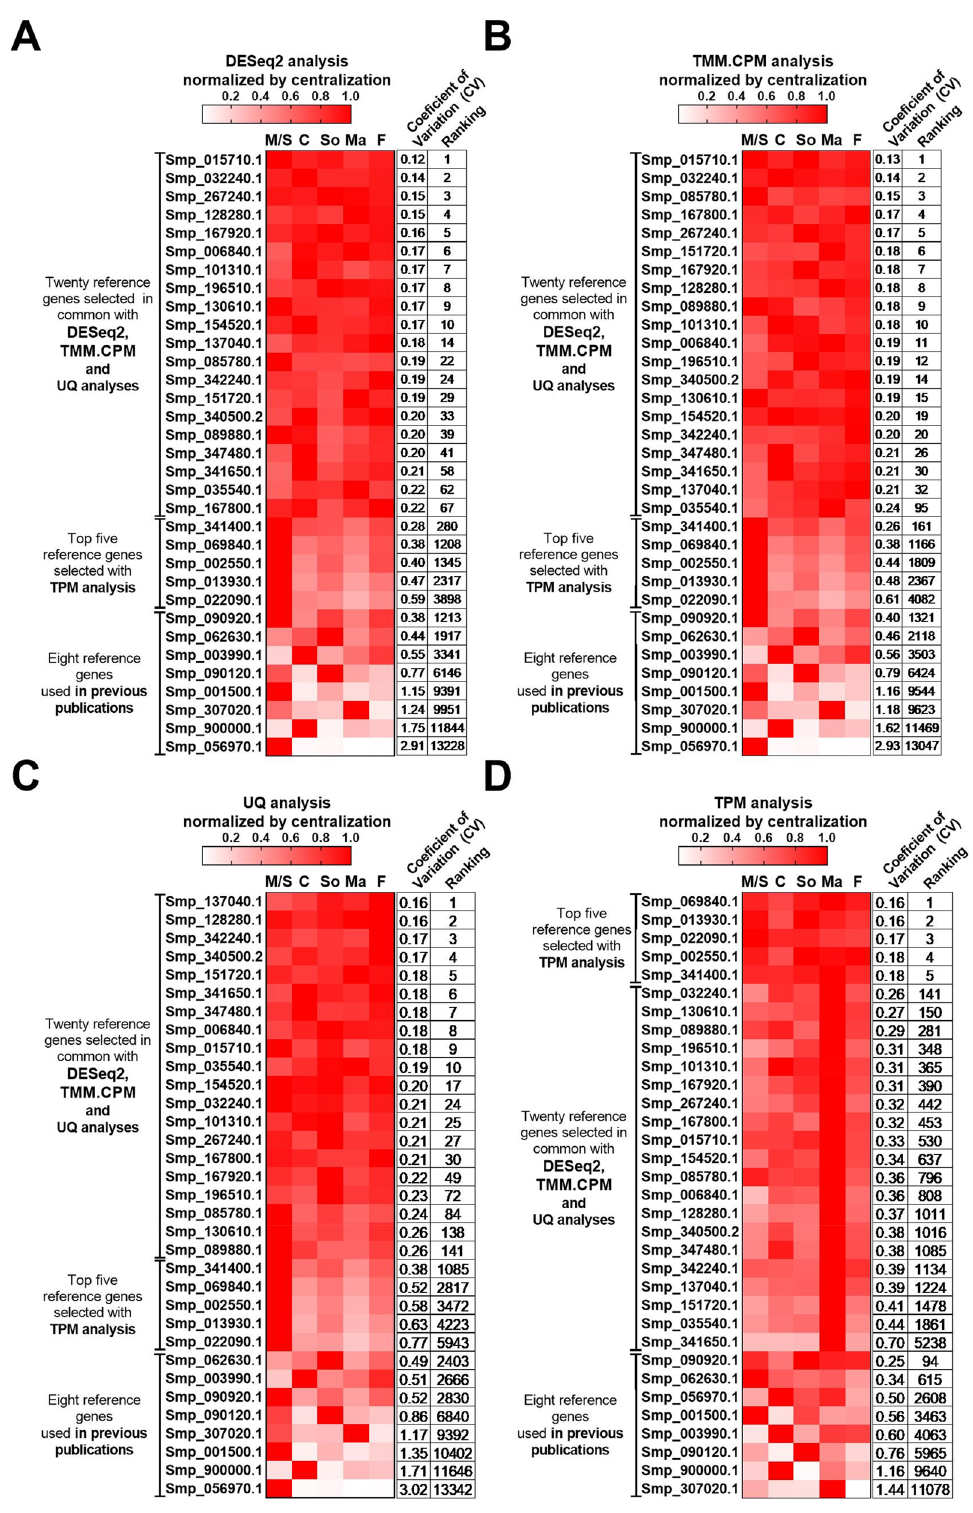
Figure 2. Expression patterns of candidate reference genes at different S. mansoni life-cycle stages. Twenty-five candidate reference genes with the lowest coefficients of variation of their expression values were selected to evaluate their stability by RT-qPCR assays. The selection was based on the analysis of 24 RNA-Seq libraries from six different S. mansoni life-cycle stages (see “Methods”). In addition, eight candidate reference genes commonly used in previous publications were also selected. The heatmaps were built based on the average expression values of each gene from all libraries used for each life cycle stage analyzed and were calculated for each RNA-Seq normalization method, namely ( A ), DESeq2; ( B ), TMM.CPM; ( C ), UQ; and ( D ) TPM. Smp stands for S. mansoni protein, and the codes are related to the gene annotation. M/S miracidia/sporocysts, C cercariae, S 48-h-schistosomula, Ma adult males, F adult females. The expression coefficient of variation and each gene’s ranking across the different RNA-Seq normalization methods are reported on the two columns at right in each